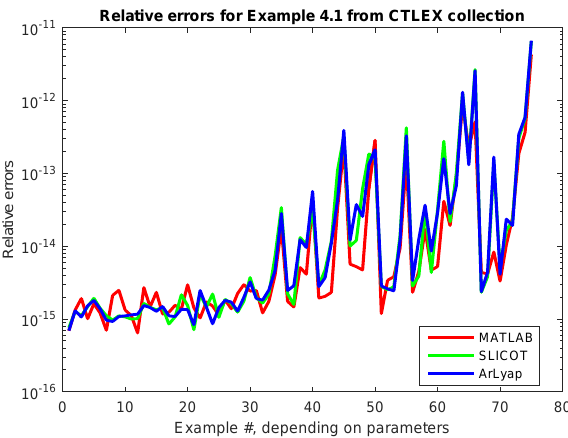
Figure 1. Relative errors for CTLEX 4.1 series of examples.